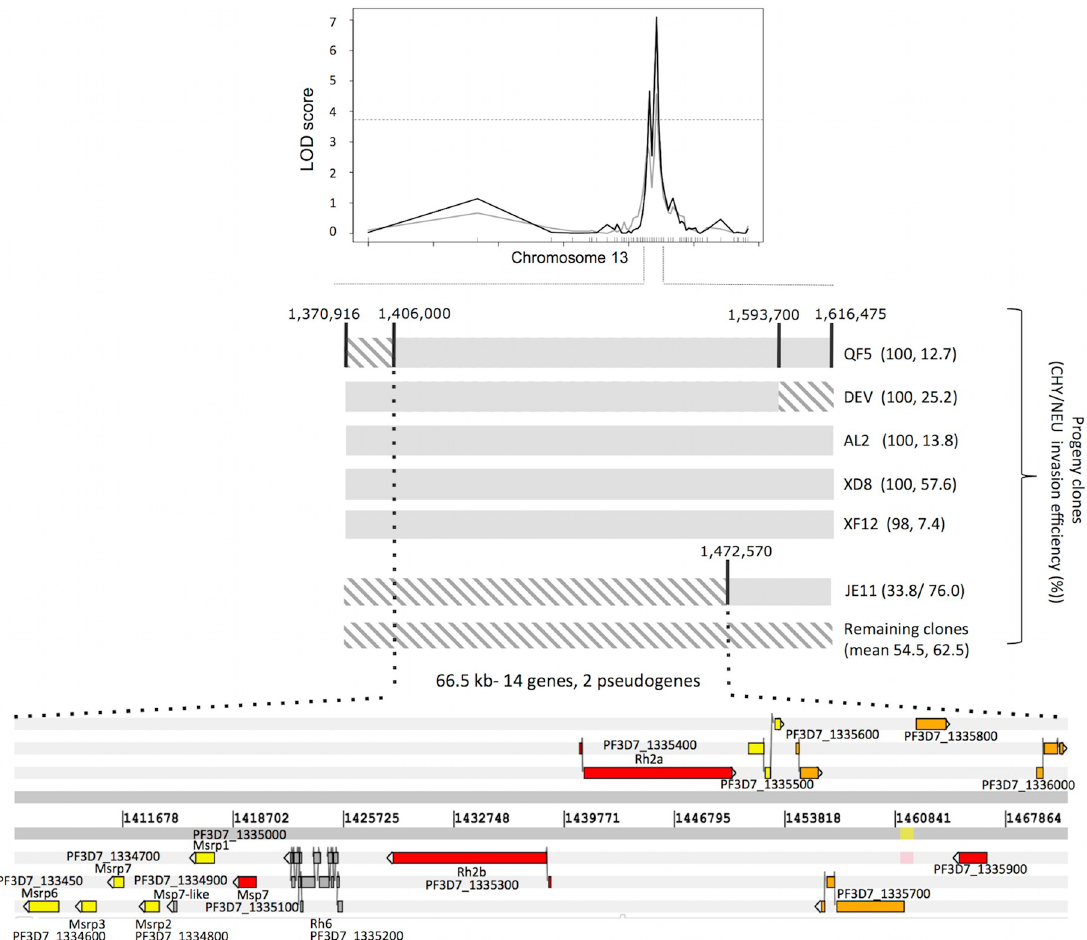
Fig 3. Fine mapping the invasion-associated QTL on chromosome 13. Map of the chromosome 13 region linked to CHY and NEU invasion phenotypes. By comparing the chromosomal segments inherited from each parental strain in the progeny clones (solid grey segments represent GB4 genome sequence, open diagonal grey segments represent 7G8 genome sequence) with their invasion phenotypes (phenotypes in brackets are the mean invasion rates into CHY, NEU treated erythrocytes, as shown in Fig 1), the region responsible for determining these two invasion phenotypes can be narrowed down to a 66.5kb fragment containing 14 genes.